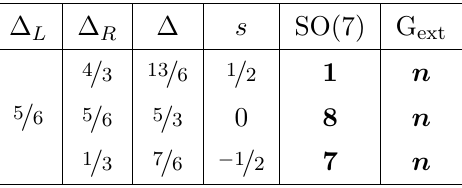
Table 5. Mass spectrum for F(4) solutions with chiral embedding (2.21a). The gauge groups are of the form SO(7) G ext (cid:2)